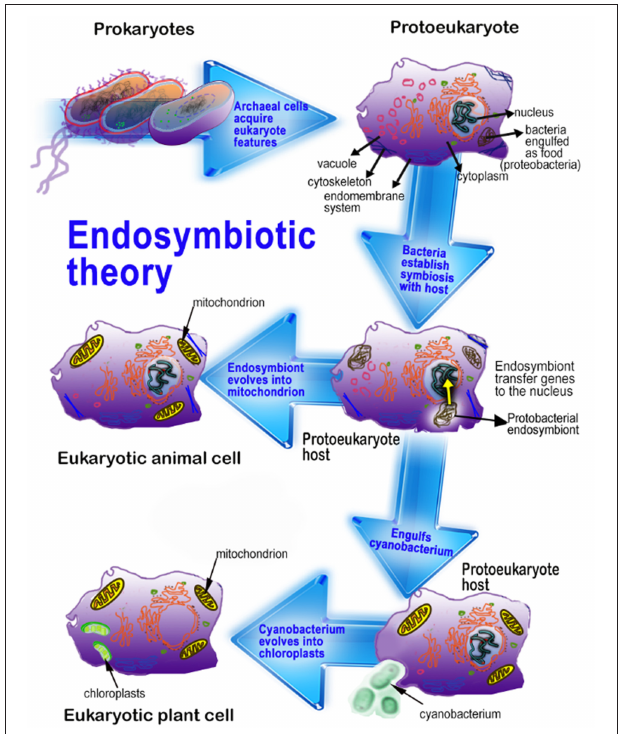
FIGURE 1 | This figure illustrates the endosymbiotic origin of mitochondria and chloroplasts. α -Proteobacteria, originally phagocytized for their nutrient value by early eukaryotes eventually evolved into mitochondria. Photosynthetic cyanobacteria were likewise phagocytized by eukaryotes and eventually formed chloroplasts. Since plants have both mitochondria and chloroplasts, plant cells generally have higher concentrations of melatonin than do animal cells. Adapted from Reiter et al.